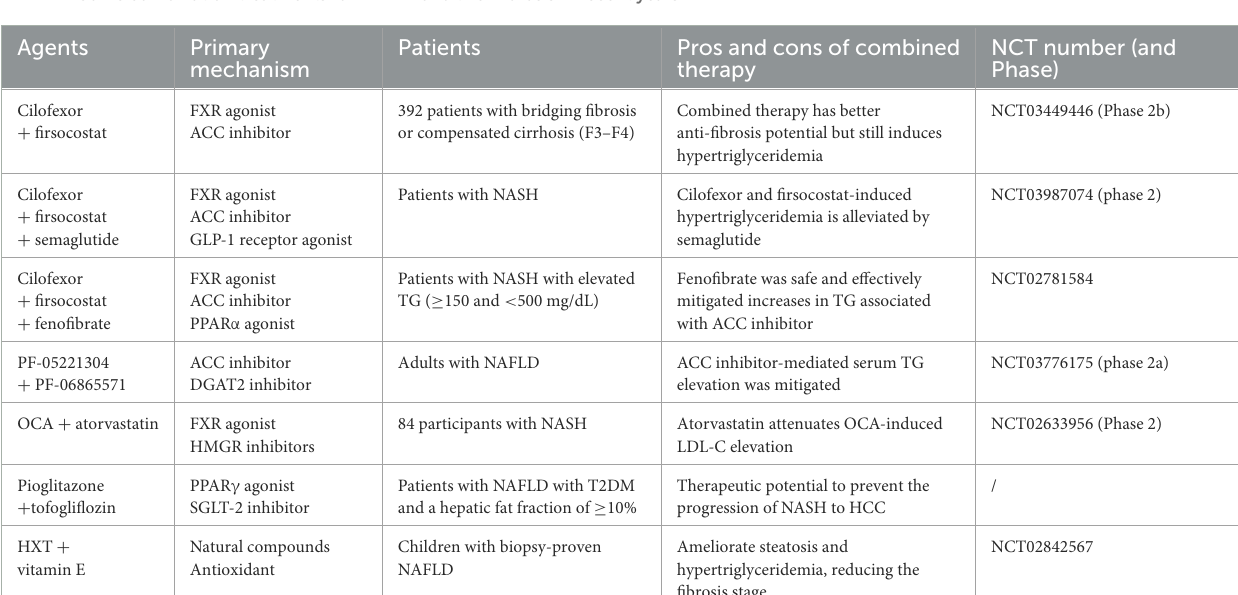
TABLE 2 Some combination treatments for MAFLD and liver fibrosis in recent